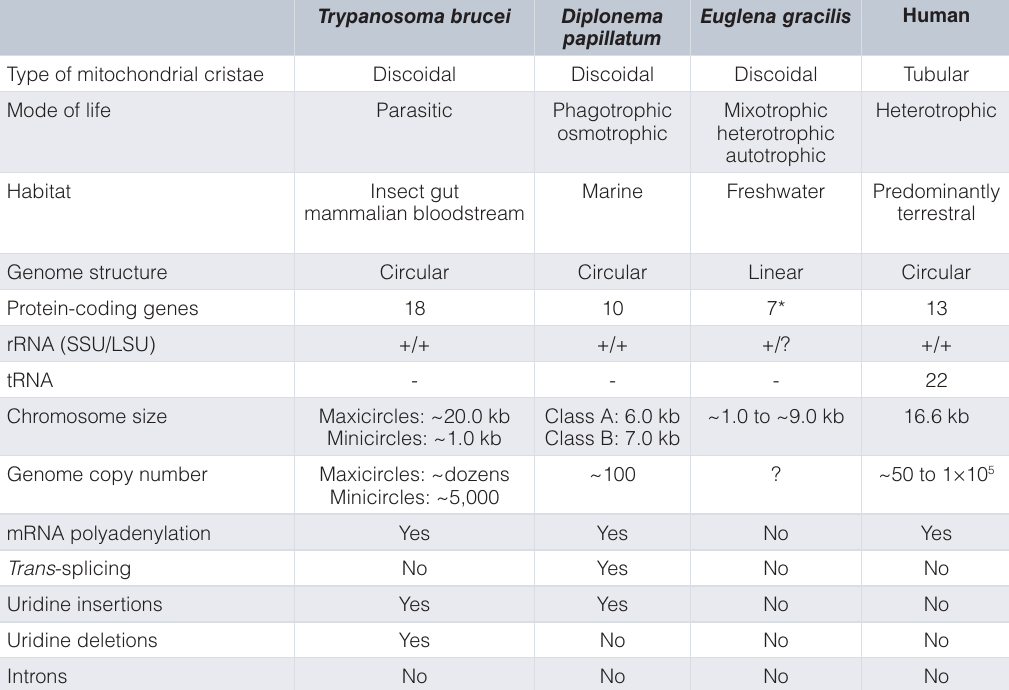
Table 1. Architecture and gene content of mitochondrial genomes of representative euglenozoans and humans. Trypanosoma brucei Diplonema Euglena gracilis Human papillatum Type of mitochondrial cristae Discoidal Discoidal Discoidal Tubular Mode of life Parasitic Phagotrophic Mixotrophic Heterotrophic osmotrophic heterotrophic autotrophic Habitat Insect gut Marine Freshwater Predominantly mammalian bloodstream terrestral Genome structure Circular Circular Linear Circular Protein-coding